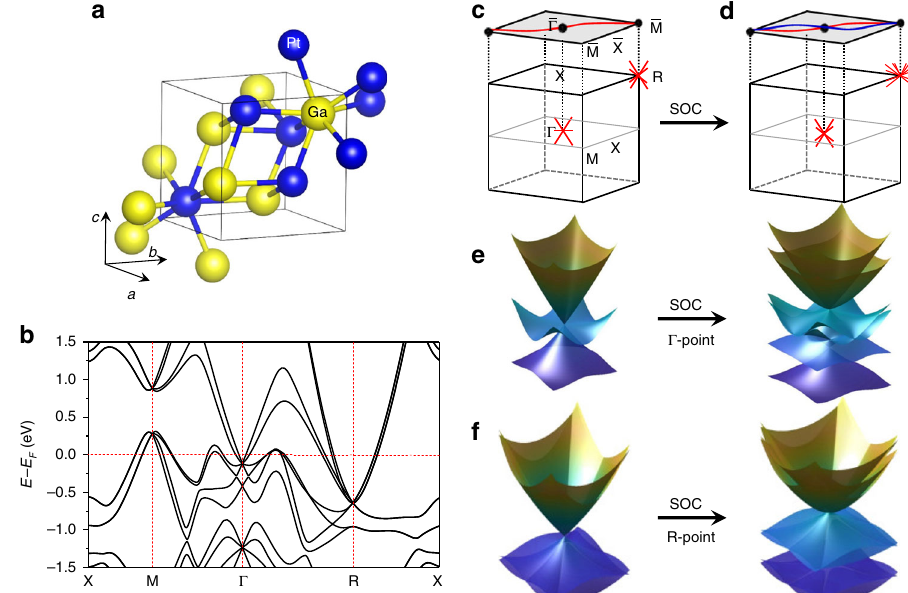
Fig. 1 Effect of strong SOC on chiral topological states. a Chiral crystal structure of PtGa with space group P 2 1 3 (No. 198). b Ab initio calculated bulk-band structure of PtGa along high-symmetry lines with SOC. c Bulk BZ with (001) surface of PtGa along with corresponding high-symmetry points. The effect of strong SOC and spin splitting of the topological states in the whole BZ of PtGa ( d ), and the multifold fermions at the Γ ( e ) and R point ( f